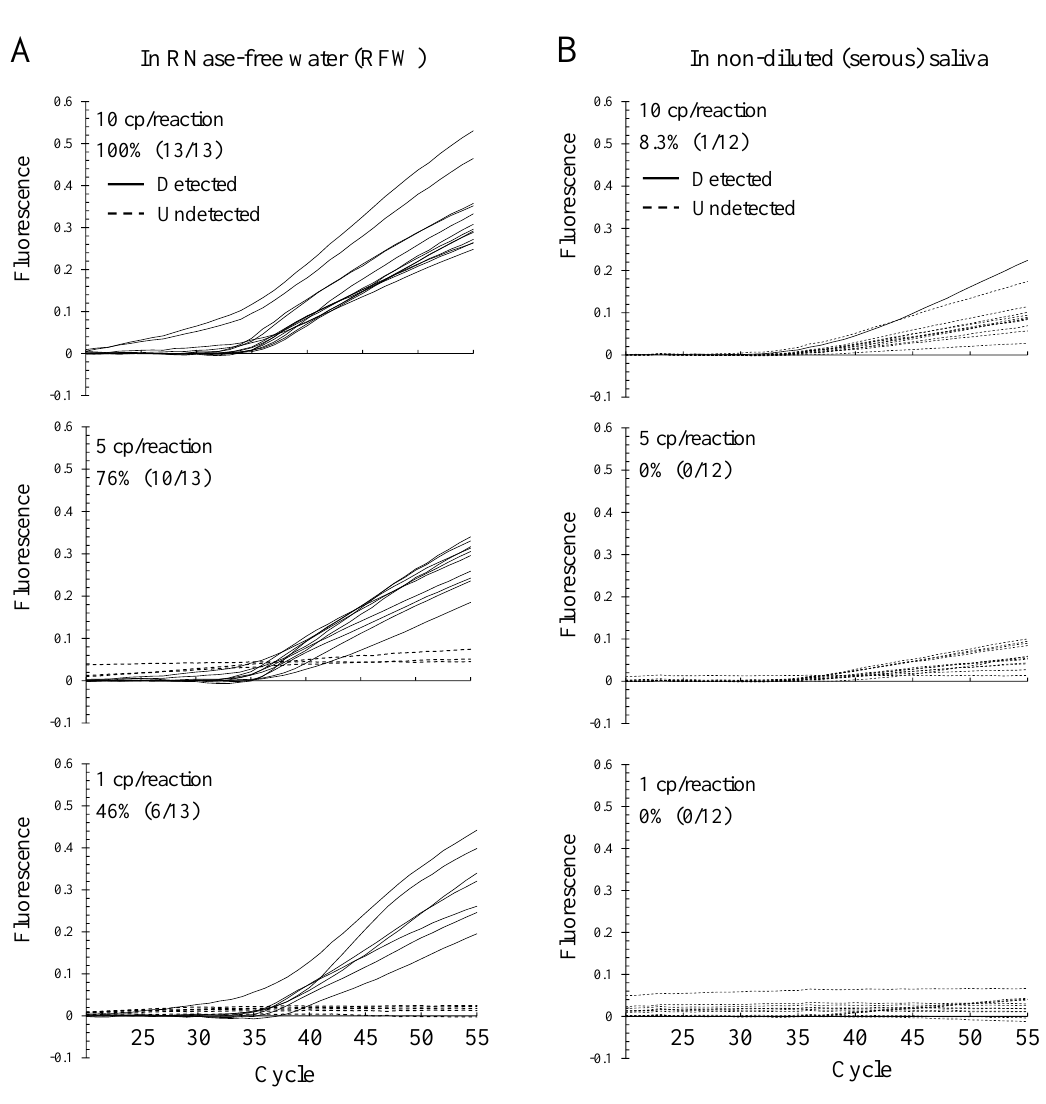
Figure. 4 Detection rate of N2 in the samples containing low concentrations of SARS-CoV-2 RNA